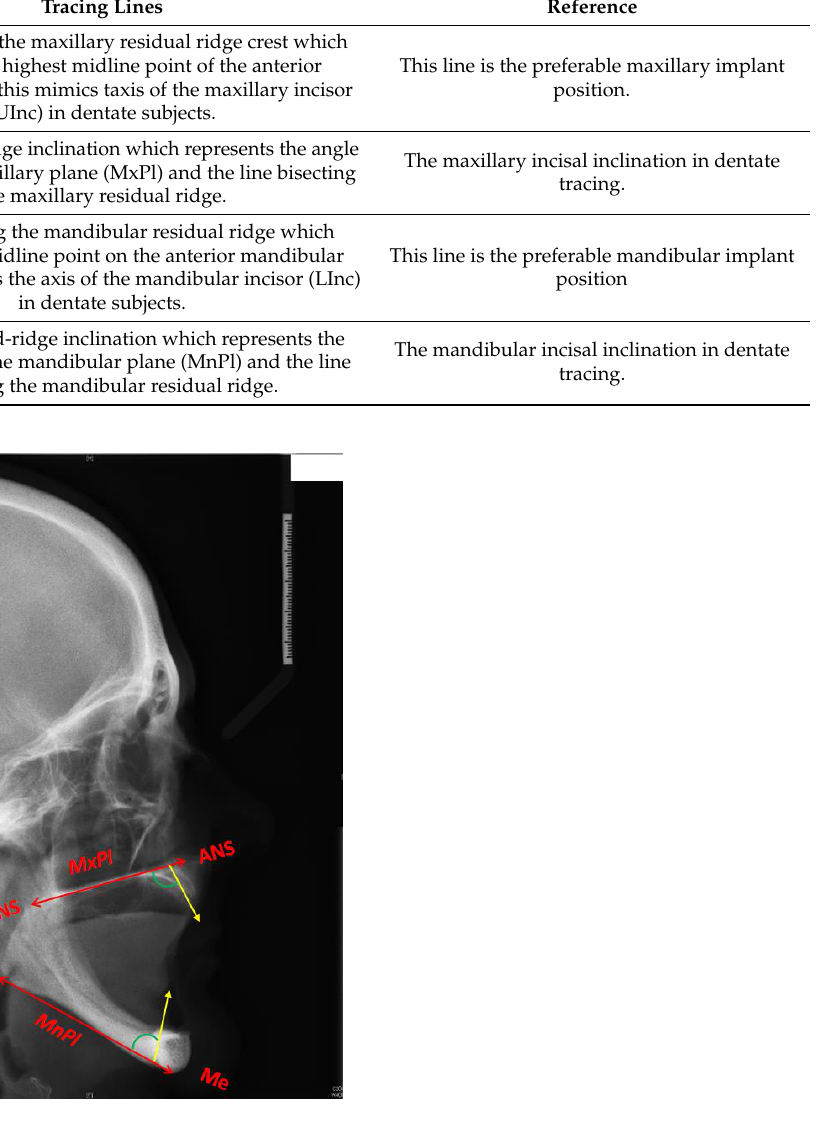
Figure 1. Tracing template used in this study: the red line in the maxillae connecting the anterior and posterior nasal spine (ANS-PNS line) represents the maxillary plane reference (MxPl); the red line in the mandible connecting the menton and the gonion (Me-Go line) represents the mandibular plane reference (MnPl); the yellow line in the maxillae is the line bisecting the maxillary residual ridge; the yellow line in the mandible is the line bisecting the mandibular residual ridge. The angles in green represent the maxillary and the mandibular incisal inclination adopted from dentate tracing. Table 1. Landmarks added by using the lateral cephalometric dentate tracing as guidance.